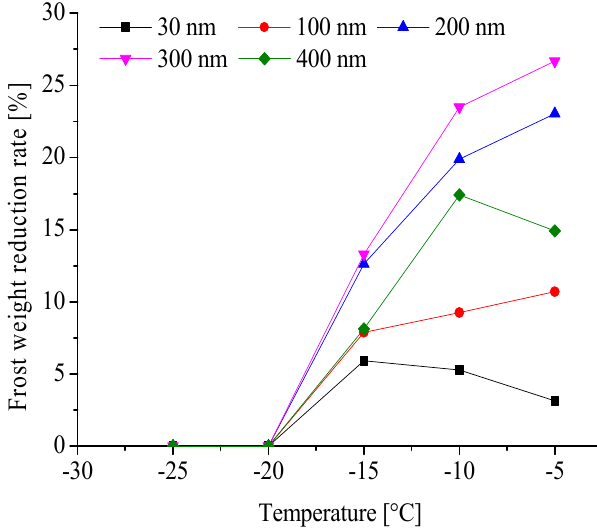
Figure 21. Variations of frost weight reduction rate of the nanoporous diameter aluminum plates compare to the polished aluminum plates at φ = 90%.